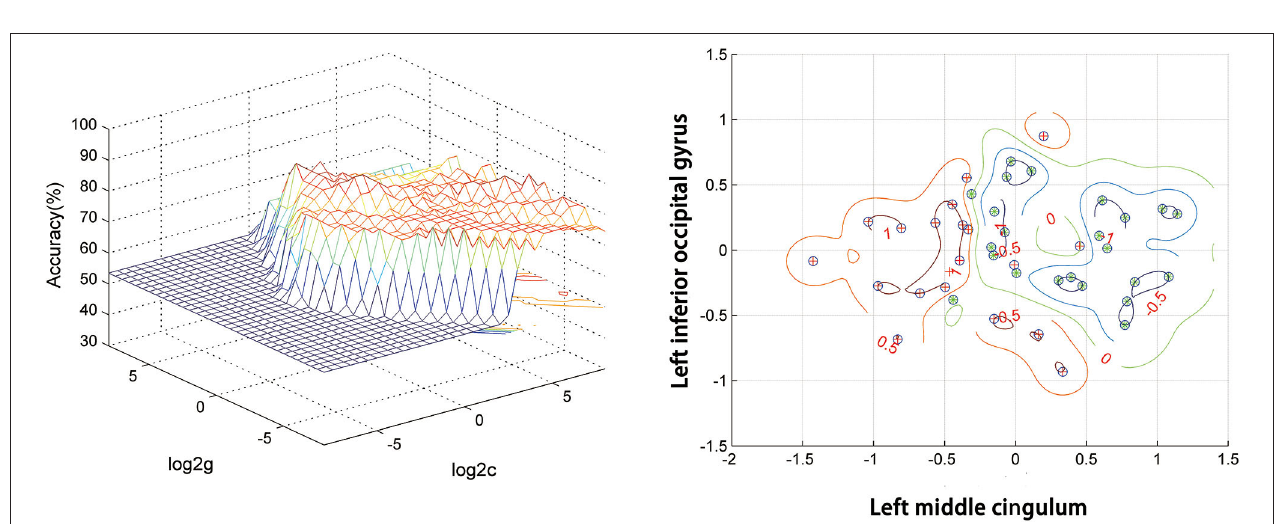
FIGURE 2 | The accuracies in differentiating patients from controls of six brain regions with abnormal ReHo values and combinations of them. A represents the left middle cingulum; B represents the right middle cingulum; C represents the right superior MPFC; D represents the right superior frontal gyrus/middle frontal gyrus; E represents the left inferior occipital gyrus; F represents the left superior temporal gyrus. ReHo, regional homogeneity; MPFC, medial prefrontal cortex.